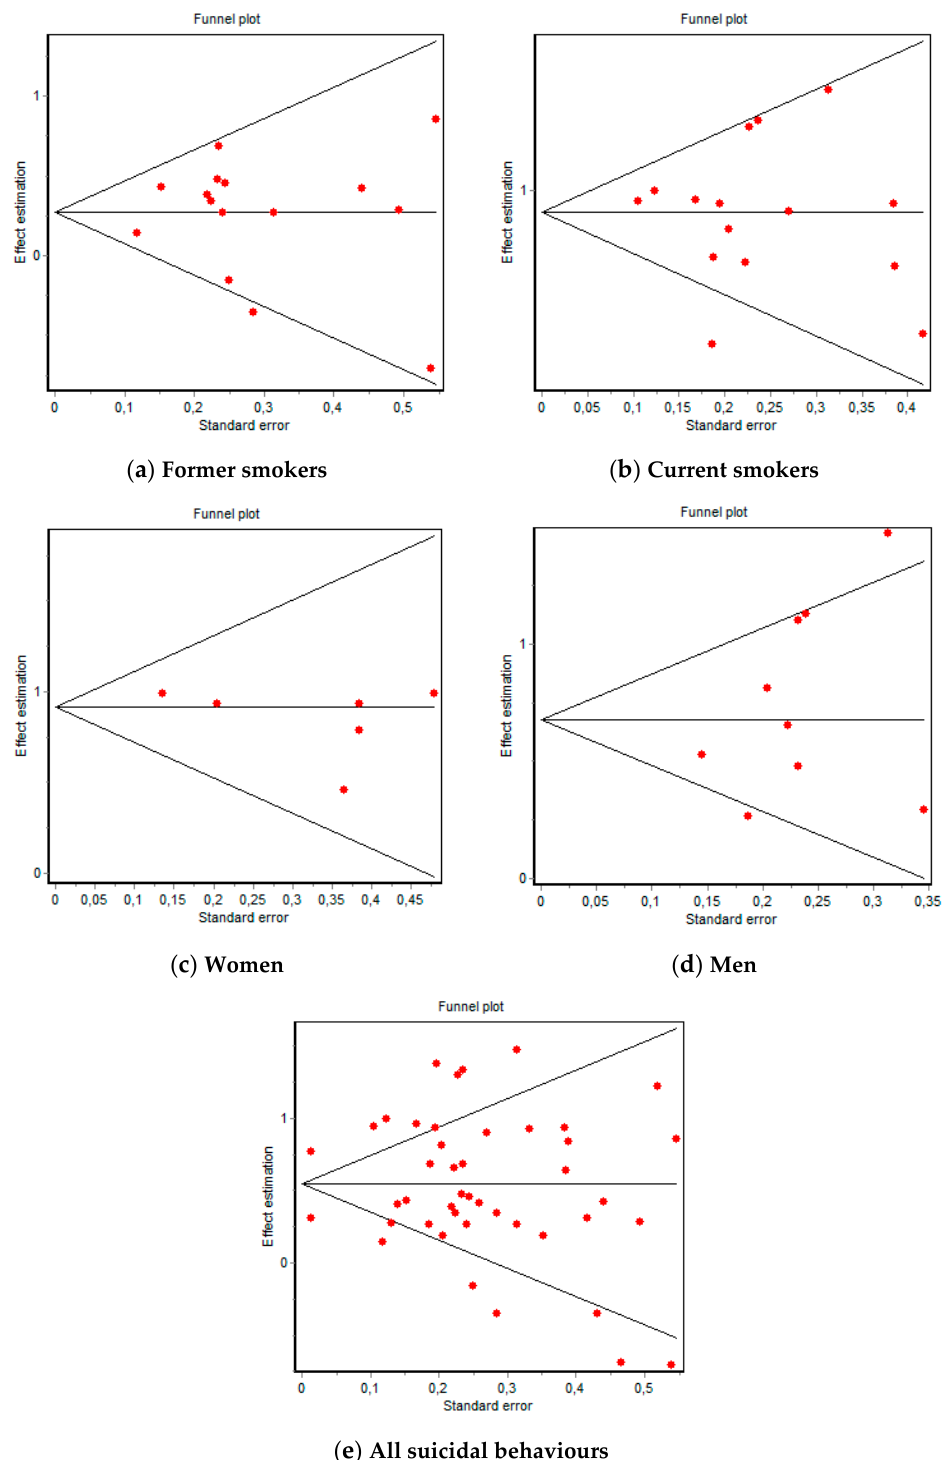
Figure 5. Funnel plots of suicide and all suicidal behaviours (ideation, plans, attempts, and death by suicide).